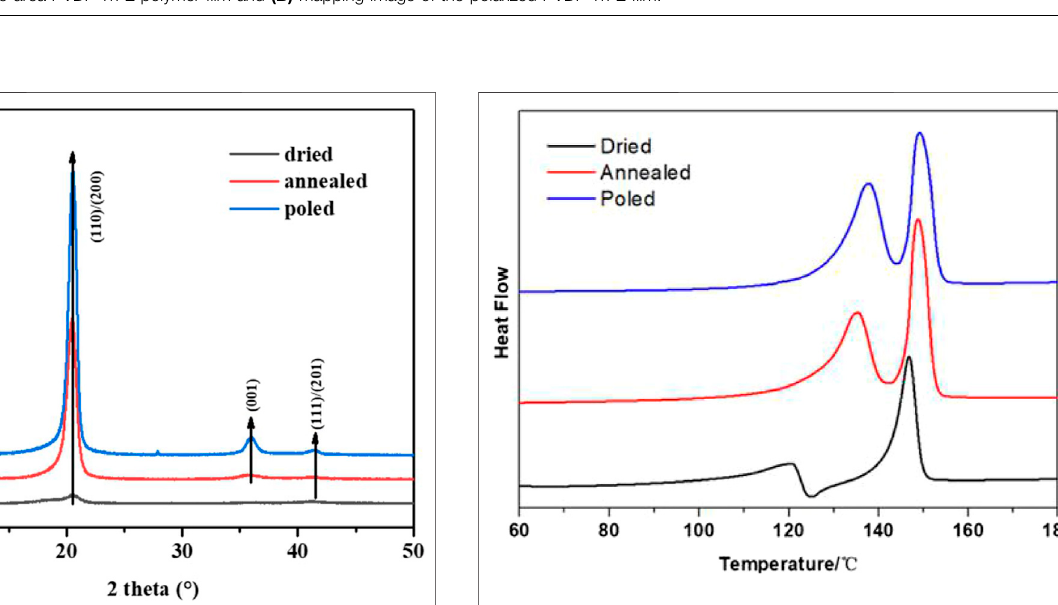
FIGURE 6 | DSC curves of PVDF-TrFE fi lms after drying, annealing, and poling.